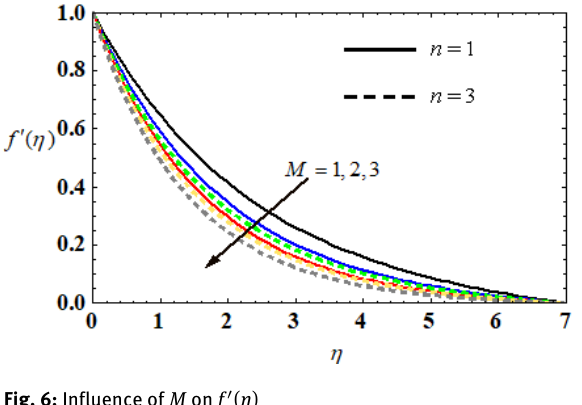
Fig. 6: Influence of M on f (cid:48) ( η ) It is evident from Figure 10 that increasing stretch- ing ratio parameter reduces the velocity in x - direction as well as both the temperature and concentration, while the velocity in y -direction exhibits the opposite behaviour (Figure 11). Generally increasing the stretching parameter